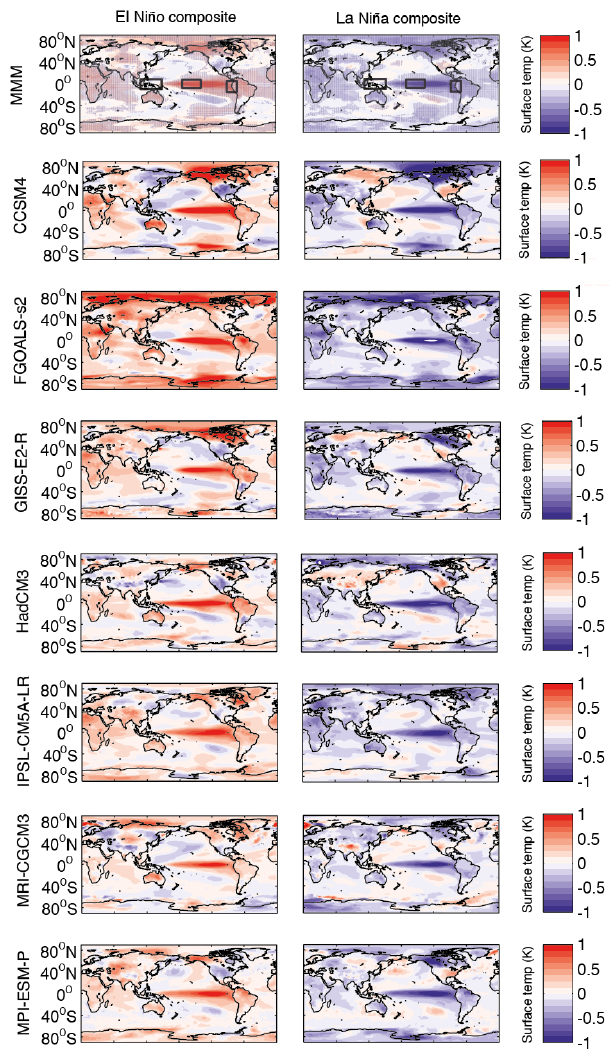
Figure 1. Composited anomaly maps for surface temperature (K) for CMIP5 models (left, El Niño episodes; right, La Niña episodes) for historical experiment, showing multi-model mean (MMM) and each model. Rectangular boxes indicate the West, Central and East Pacific regions. Stippling indicates where more than 80% of the models agree on the sign of the ENSO-associated